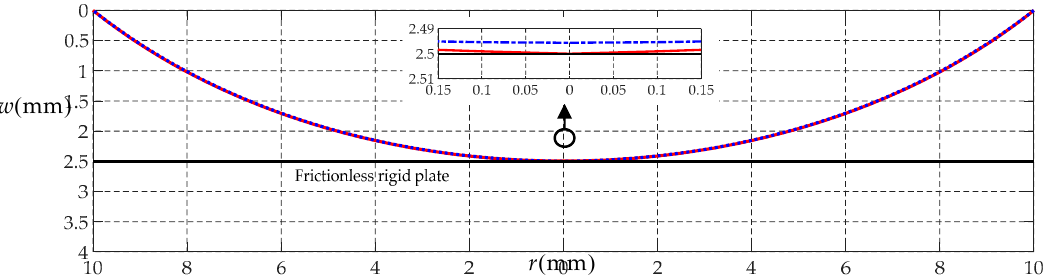
Figure 3. Variations of w with r calculated by the solution presented in [25] for q = 0.0554 MPa (the dash-dotted line) and by the solution presented here for q = 0.0556 MPa and g = 2.5 mm (the solid line).